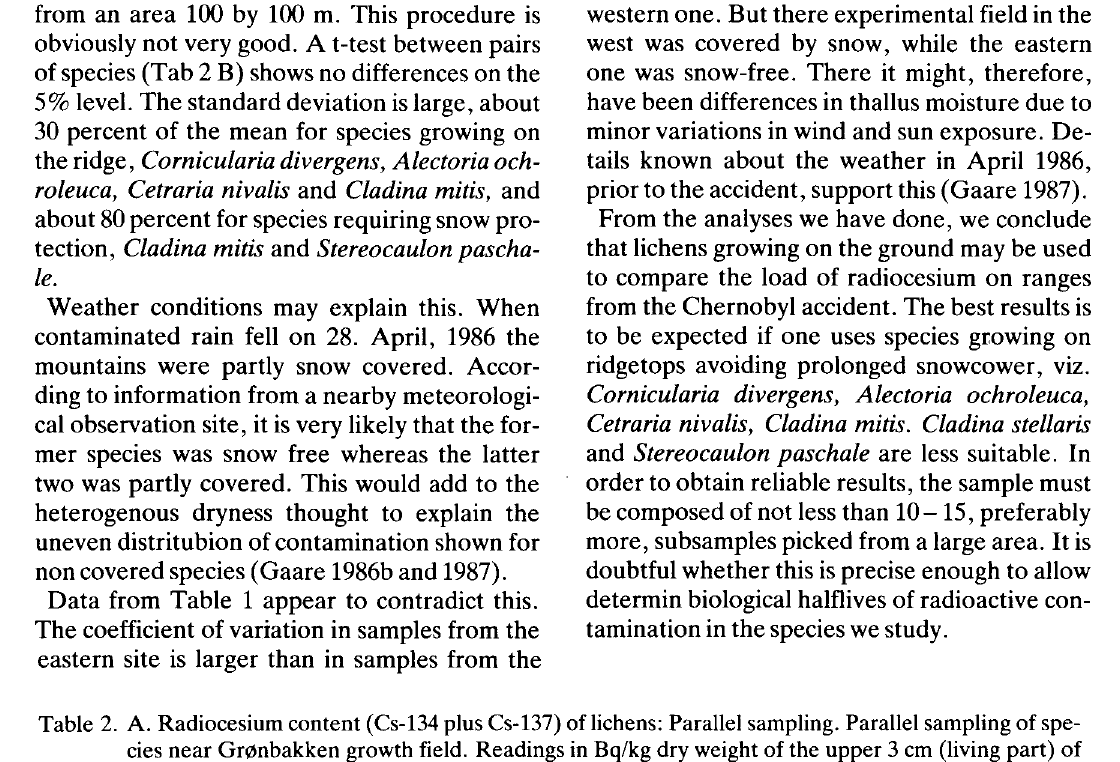
Table 2. A. Radiocesium content (Cs-134 plus Cs-137) of lichens: Parallel sampling. Parallel sampling of spe des near Grønbakken growth field. Readings in Bq/kg dry weight of the upper 3 cm (living part) of the thallus.